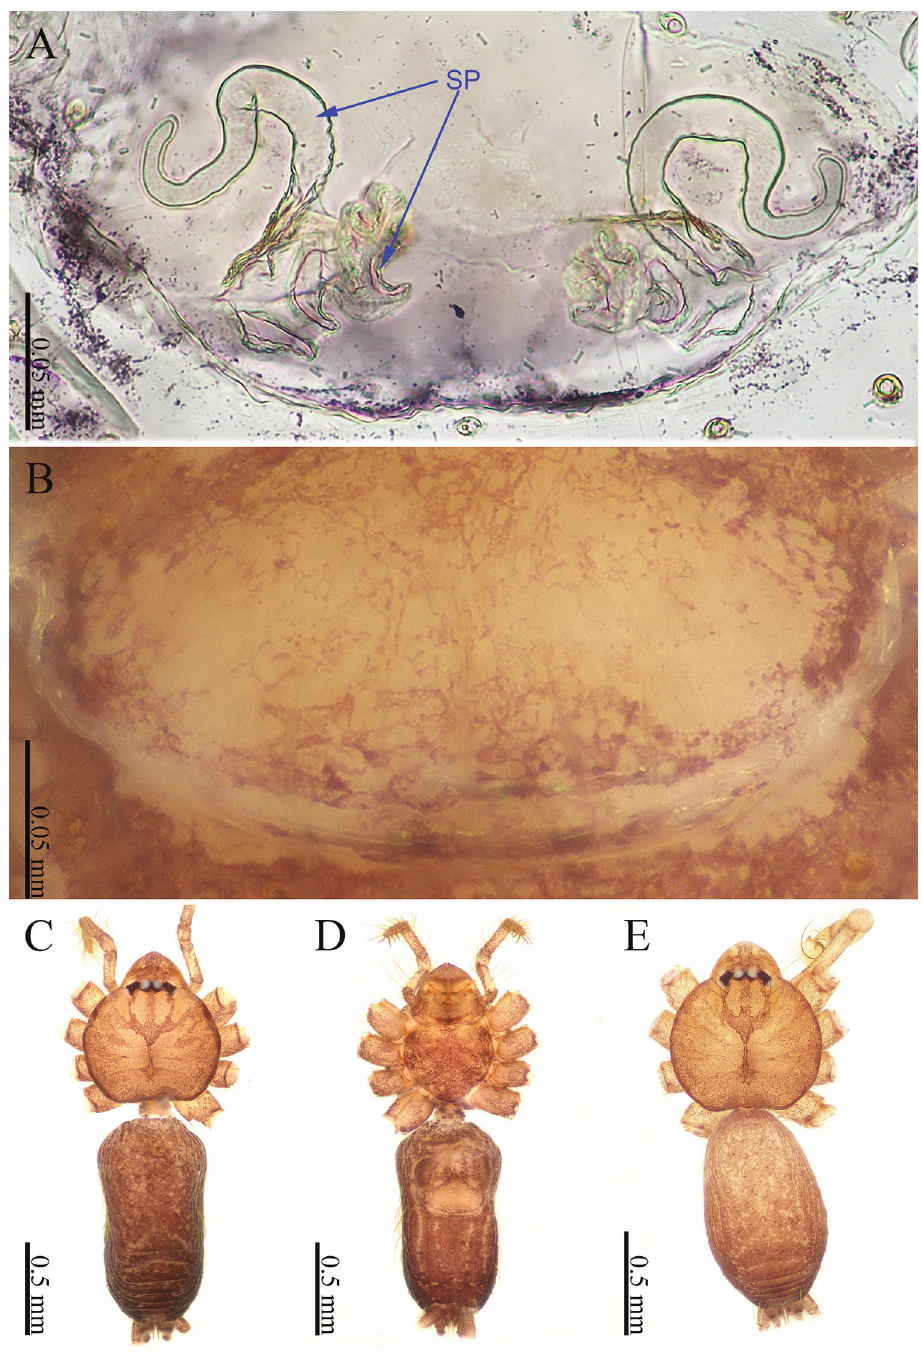
Figure 4. Sinoderces luohanensis Li & Li, sp. nov., male holotype and female paratype A internal genita- lia, dorsal view B female epigastric furrow, ventral view C Female habitus, dorsal view D female habitus, ventral view E male habitus, dorsal view. Abbreviation: SP